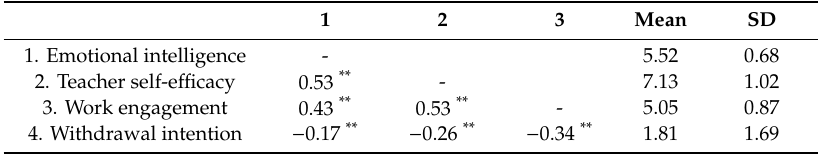
Table 2. Descriptive statistics and intercorrelations among